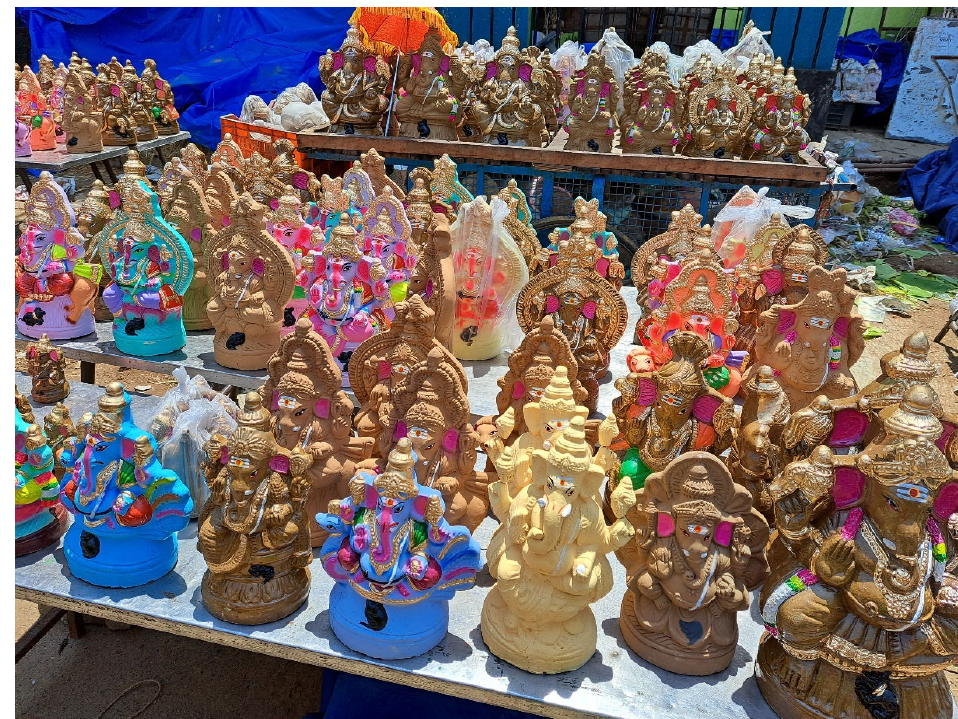
Figure 9. Street vendors sell mass-produced clay (mixed) Ganeshas. Picture taken by author, 30 Au- gust 2022, Chennai.